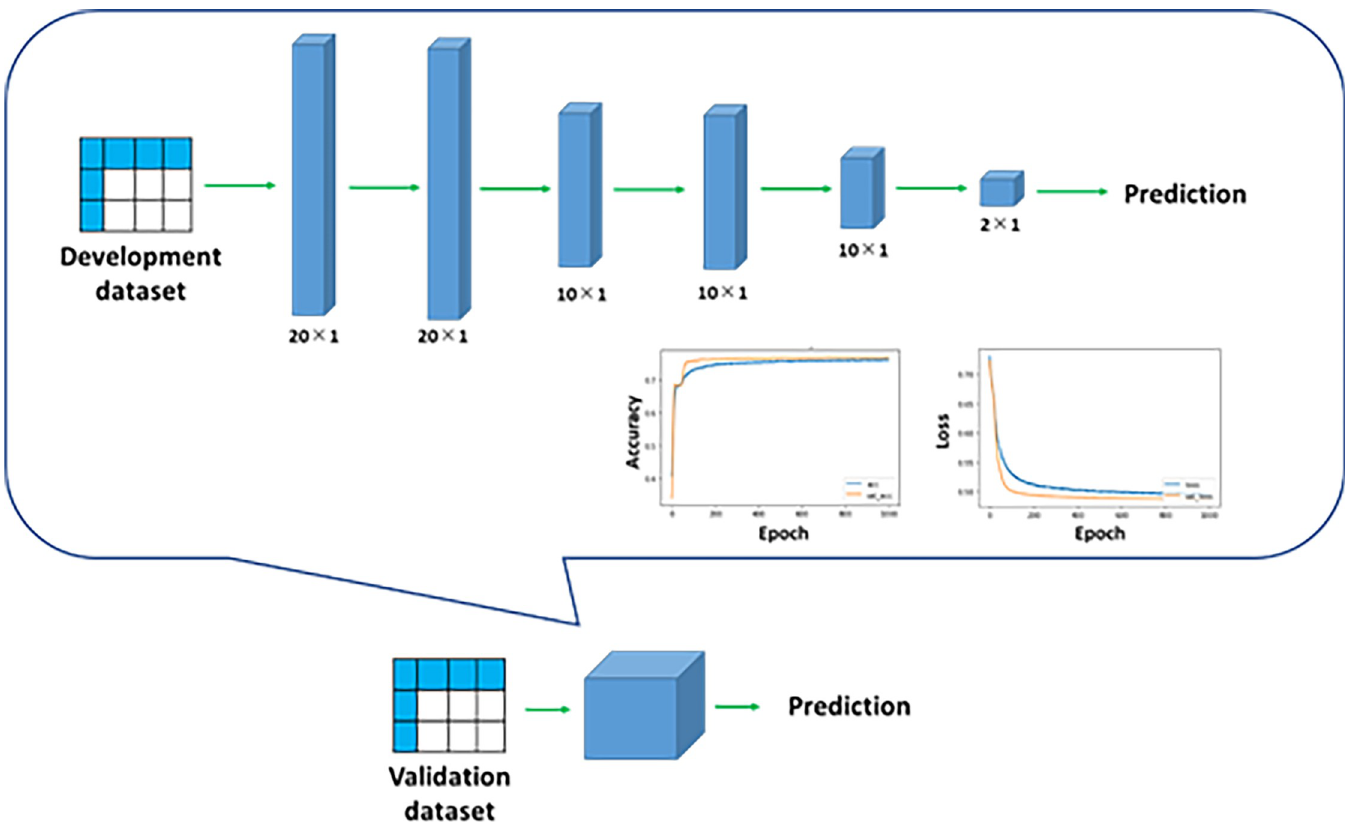
Fig 4. Deep learning model for prediction of 5-year death. The deep learning model for the prediction of 5-year death was developed similarly to the model for 1-year death. The trained model was applied to the validation dataset.